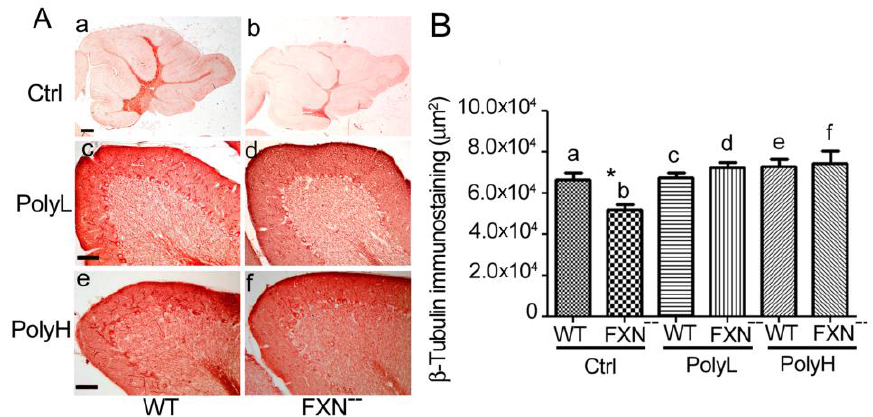
Figure 2. ( A ). β -tubulin expression in the cerebellum from six-month-old WT (a,c,e) and FXN – mutant (b,d,f) mice. In both genotypes, vermal sections are shown in either control mice, i.e., in the absence of any treatment (Ctrl a,b), or in mice undergoing treatment with low dosage (PolyL: 0.0185 mg / g of food, c,d) or high dosage (PolyH; 0.185 mg / g of food, e,f) EGCG administration. In a,b reduced β -tubulin immunostaining indicated impaired neurogenesis in FXN – mice, which underwent recovery upon polyphenol treatment under the low (PolyL, c,d) or the high (PolyH, e,f) protocols, see also the results of the morphometric analysis in Figure 2B. Scale bars: a = 500 µ m; c, e = 50 µ m. ( B ): The results are reported of the morphometric analysis (pixels / field) of the immunostainings shown in ( A ). A p -value = 0.01, indicated by *, was considered statistically significant. In FXN – mice EGCG treatment under both the low (PolyL, c,d) and the high (PolyH, e,f) dosage protocols resulted into a recovery of neuronal marker expression compared to untreated controls (Ctrl) (compare d, f to b), indicating increased neuronal